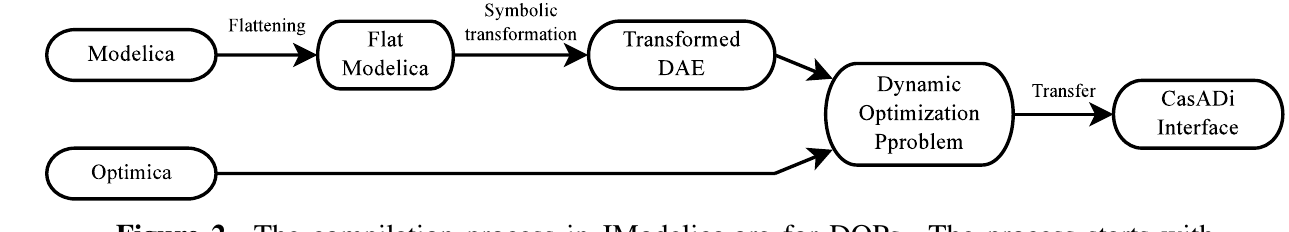
Figure 2. The compilation process in JModelica.org for DOPs. The process starts with the user-provided Modelica and Optimica code and ends with a symbolic representation of the DOP in CasADi Interface, which serves as an interface between dynamic optimization algorithms and the Modelica and Optimica